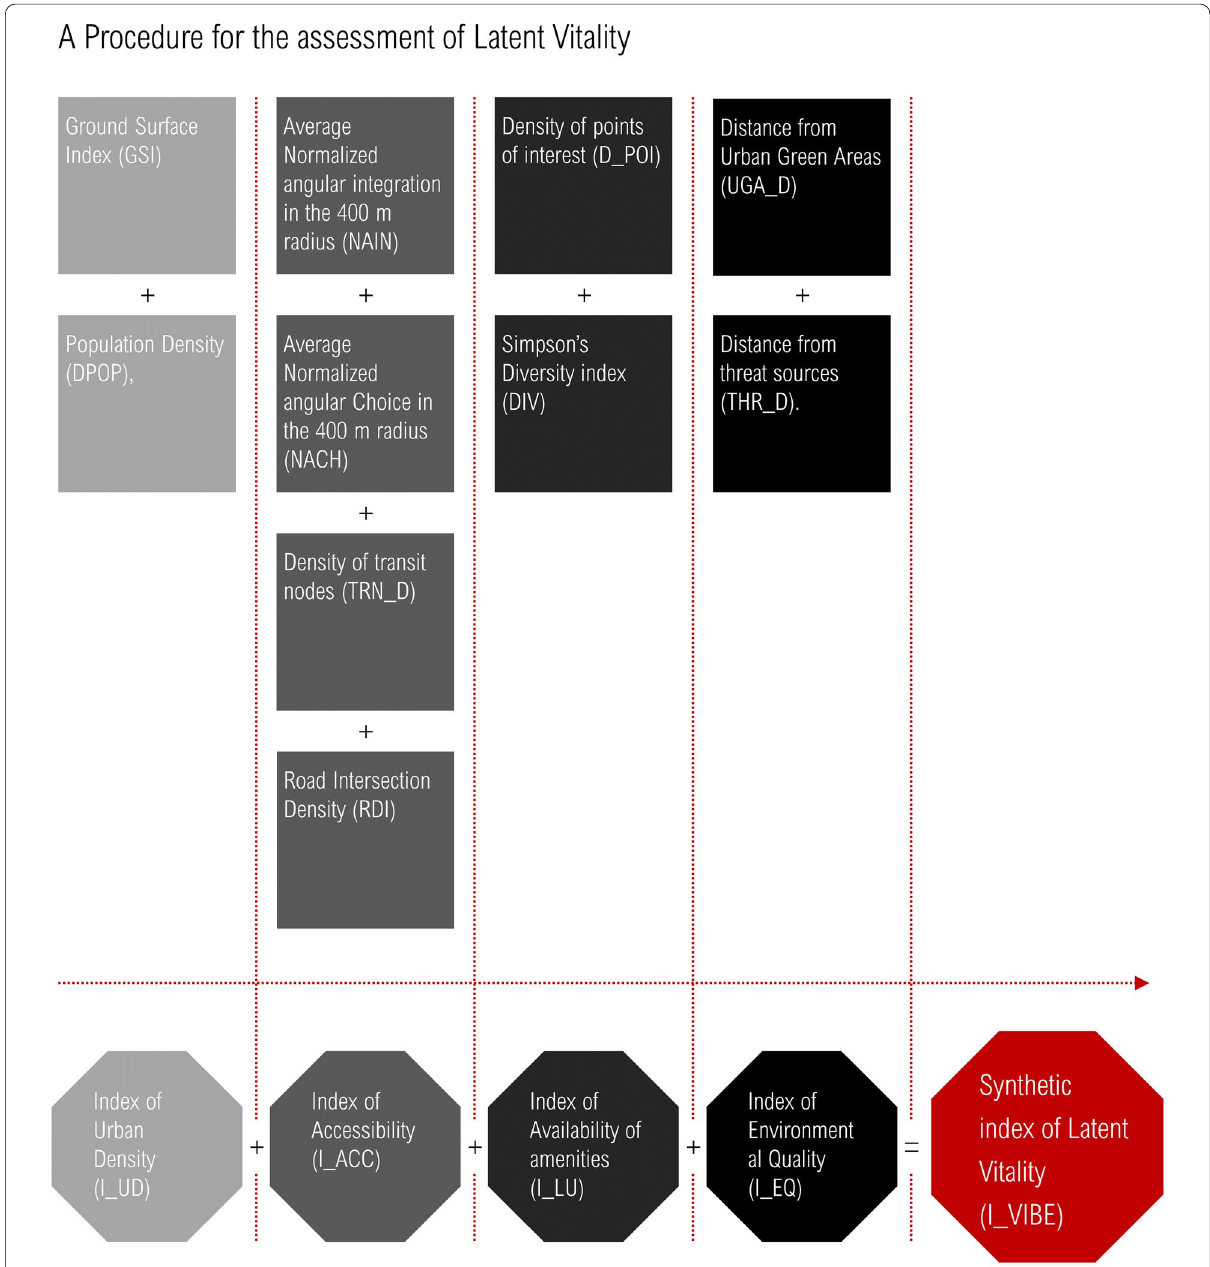
Fig. 2 Structure of the analysis of latent vitality: individual indicators, dimensional indicators, and synthetic index of the latent vitality of the urban